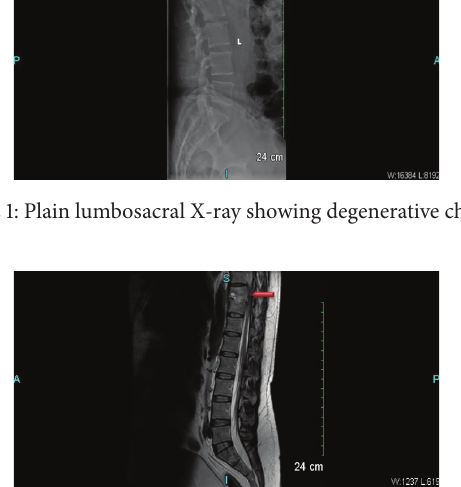
Figure 2: MRI of lumbosacral spine showing discitis at T10-T11 level (red arrow).